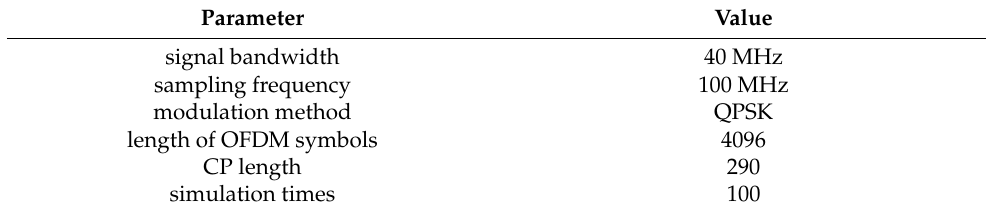
Table 1. The parameters of the simulation system.